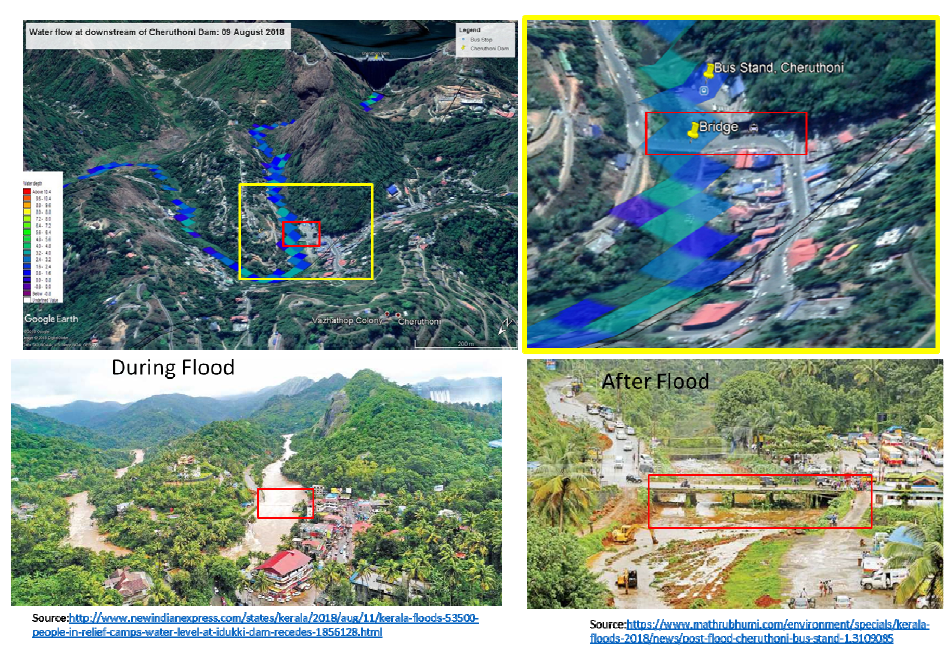
Figure 16. Flood inundation d/s of Cheruthoni dam as simulated using 1D HD model and as observed in reality from field pictures from